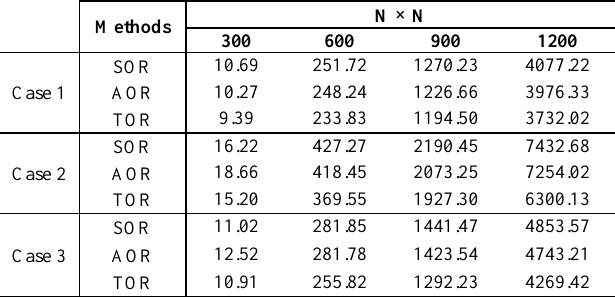
Table 2. Performance of the proposed methods in terms of execution time (in